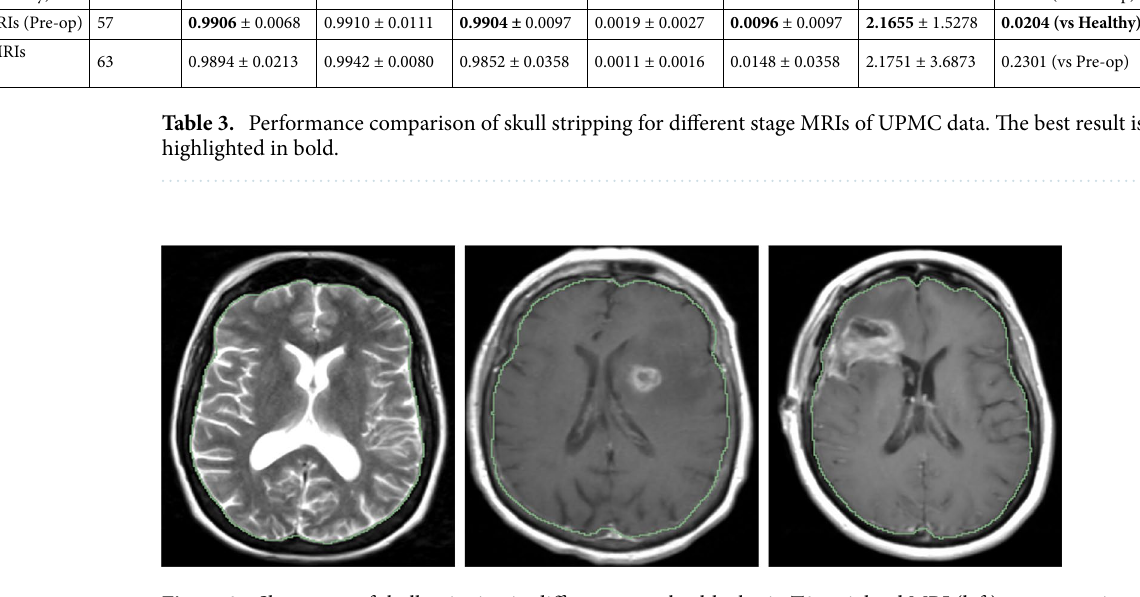
Figure 3. Showcases of skull stripping in different stage: healthy brain T2-weighted MRI (left), pre-operative T1-ce brain tumor MRI (middle), and post-operative T1-ce brain tumor MRI (right). The green contour is the boundary of skull stripping using the proposed